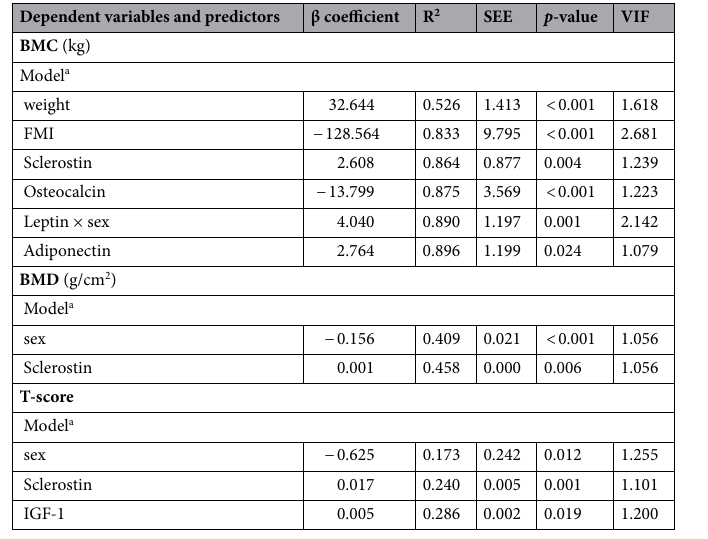
Table 5. Stepwise multiple regression analyses with BMC, BMD and T-score as dependent variables. BMC, bone mineral content; FMI, fat mass index; BMD, bone mineral content; IGF-1 , insulin-like growth factor 1; SEE, standard error of estimation; VIF, variance inflation factor. a Model: independent variables: weight, FMI, SMI, leptin, leptin × sex, adiponectin, sclerostin, osteocalcin, IL-6, hsCRP, IGF-1, age and sex.